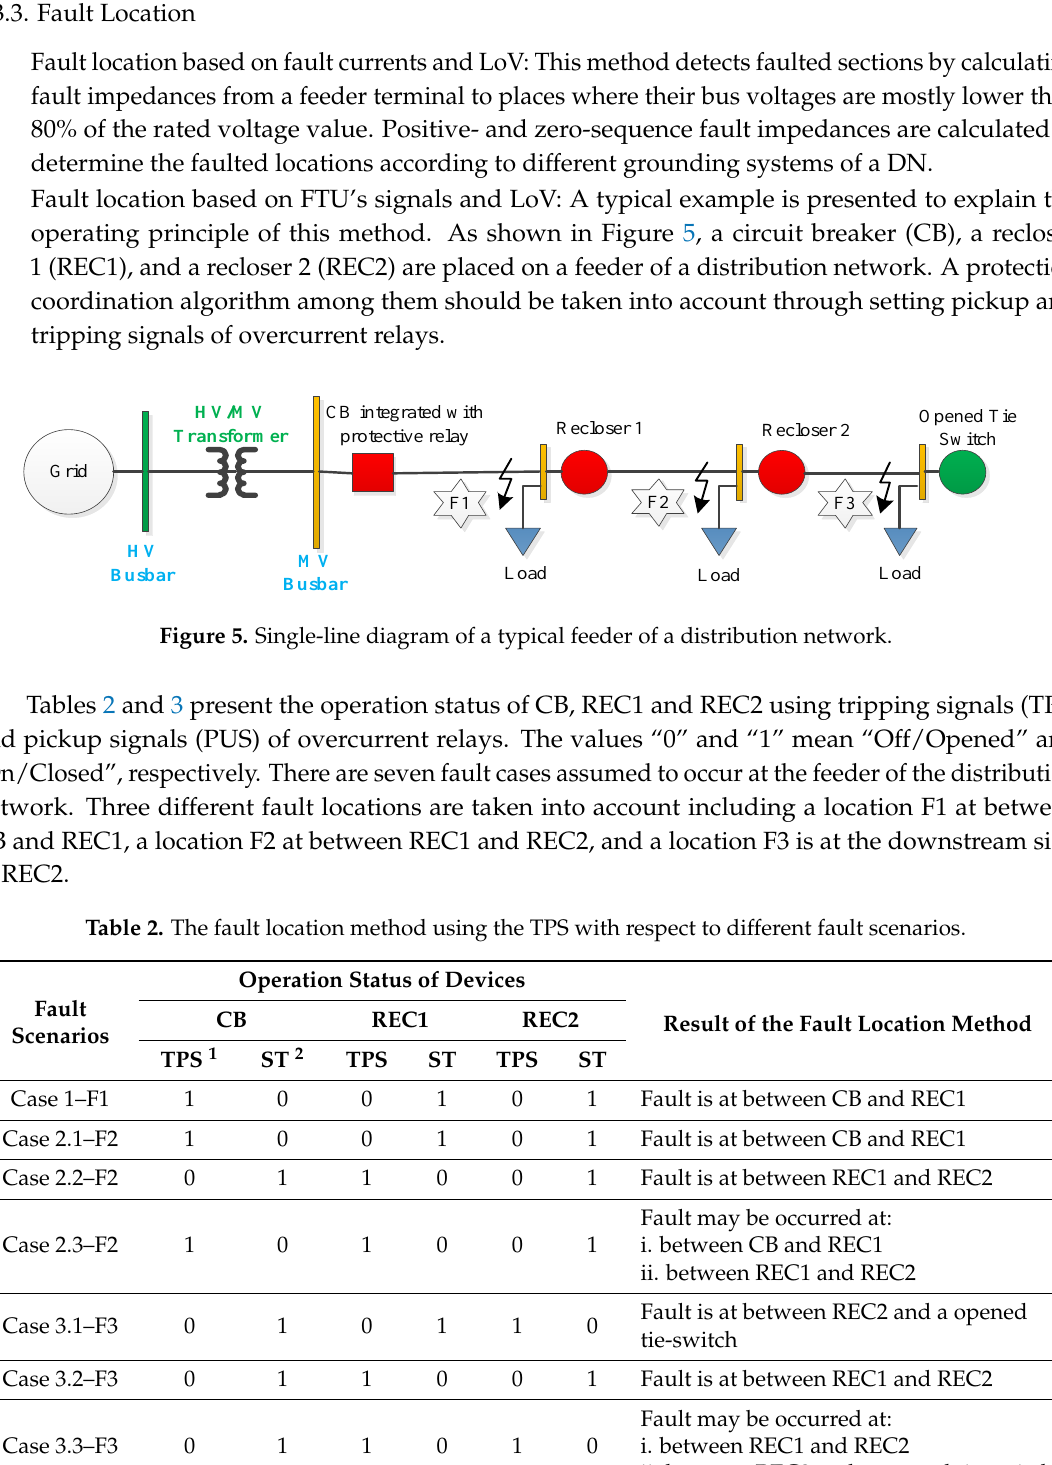
Table 2. The fault location method using the TPS with respect to different fault scenarios.